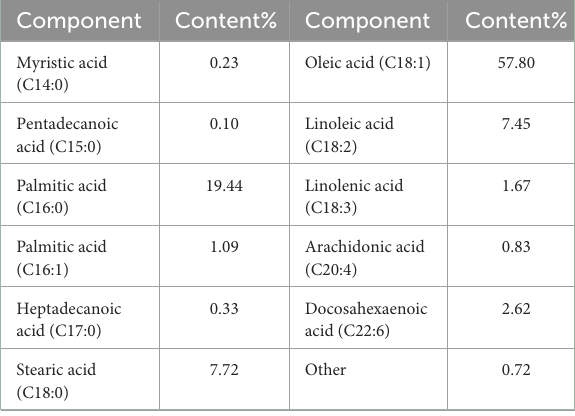
TABLE 2 Fatty acid component and content of yolk